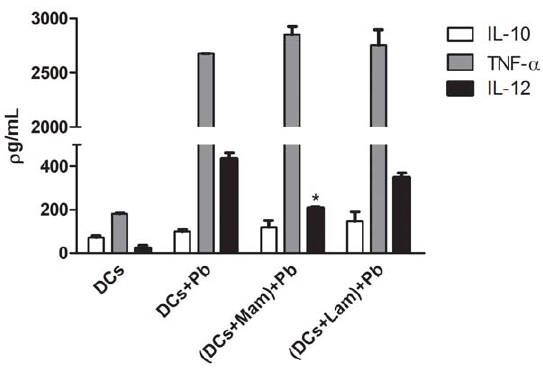
Figure 4. Effect of mannan and laminarin on cytokine secretion by murine dendritic cells infected with P. brasiliensis . Murine bone marrow-derived DCs were incubated with mannan (Man) or laminarin (Lam) at 100 and 200 m g/ml, respectively, for 30 min. Subsequently, P. brasiliensis yeast cells (Pb) were added to DCs at a ratio of 1:1, and the co-culture was incubated for 6 h. Culture supernatants were harvested and secreted protein levels were measured using ELISA. Data are reported as the mean 6 standard deviation. * P , 0.05 compared to the DCs + Pb group.